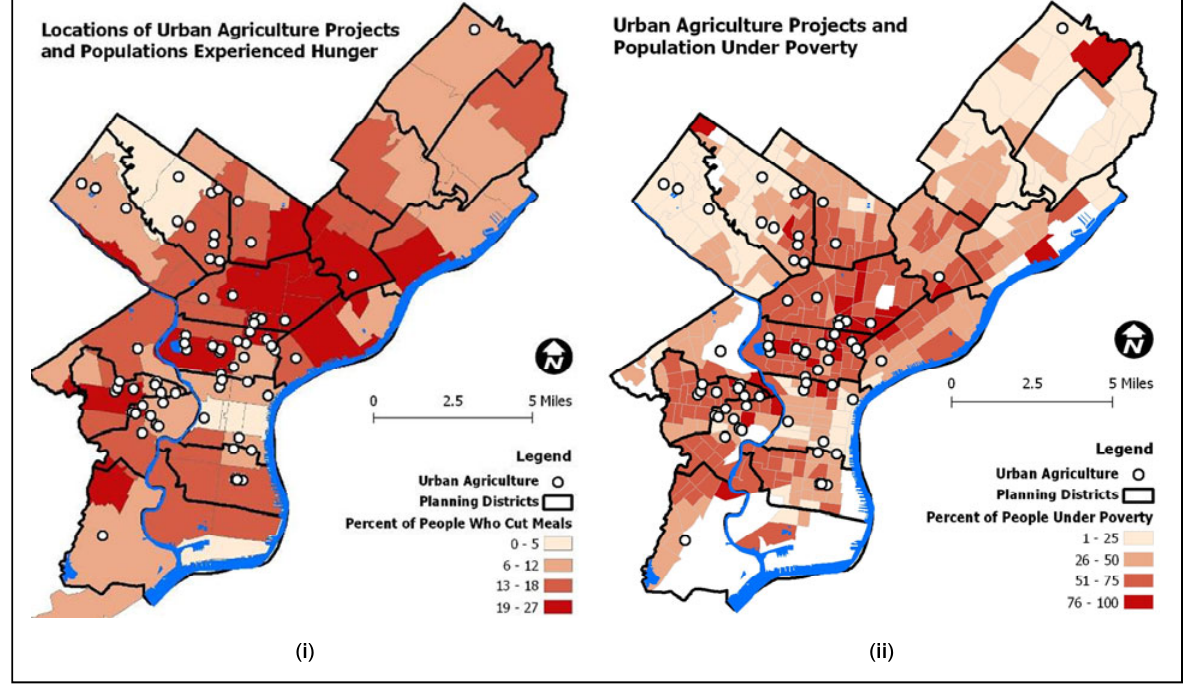
Figure 5. Spatial Connections Between Concentrations of Urban Agriculture Projects, Hunger, and